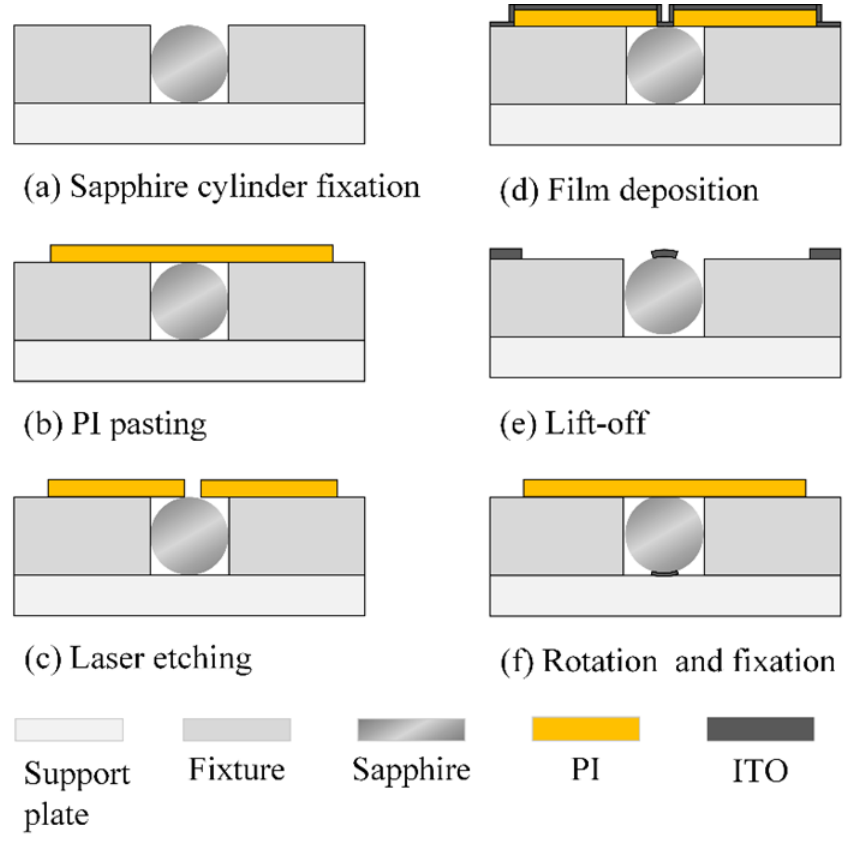
Figure 4. Graphical processing of curved films. Table 1. Sputtering values used for the deposition of thin-film thermocouple legs and